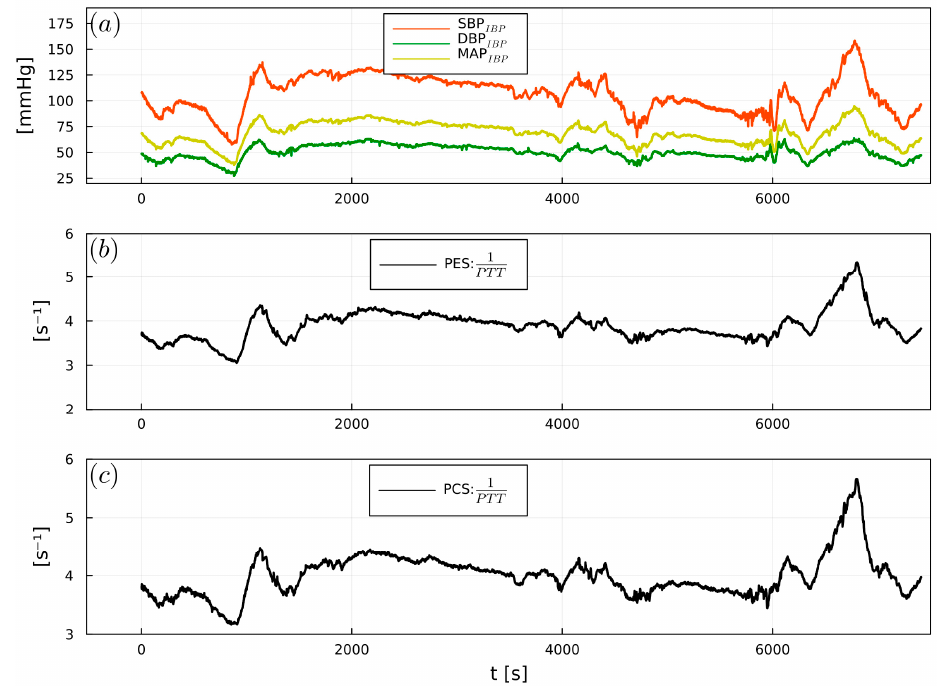
Figure 7. Example of ( a ) intraoperative SBP IBP (red), DBP IBP (green), and MAP IBP (yellow), ( b ) 1/PTT PES , ( c ) 1/PTT PCS , from a cardiac surgery patient.